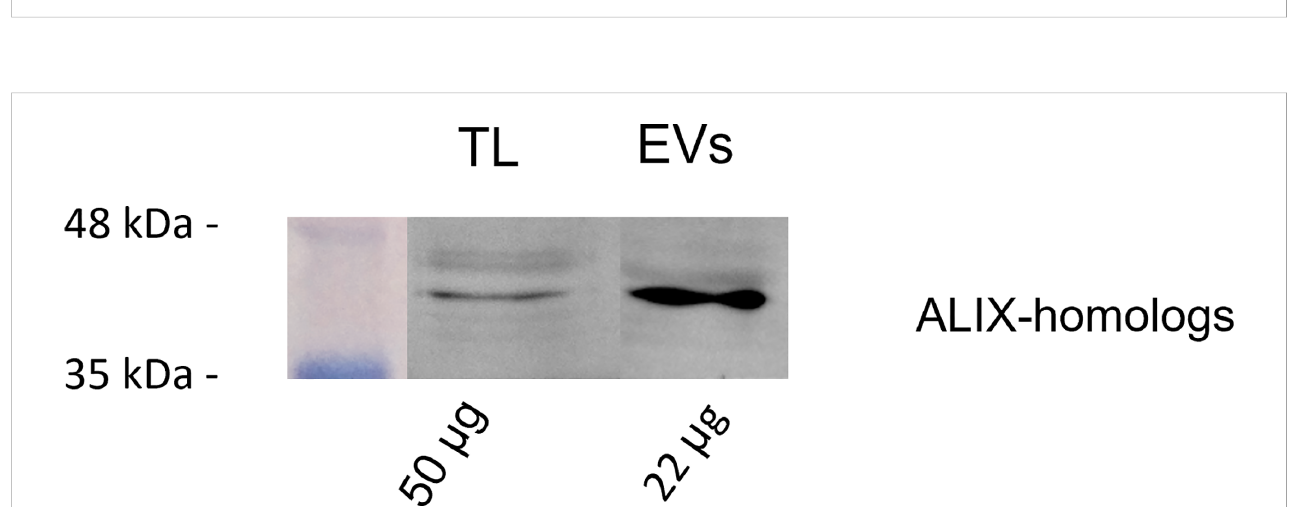
FIGURE 6 Western blot analysis of pollen total lysate (TL) and nanovesicles (EVs) fractions from germinated kiwi pollen (GKP), probed with a 1:1000 dilution of anti- ALIX rabbit polyclonal. The membranes were developed with ECL and read in chemiluminescence. On the left are reported the molecular weights of the pre-stained ladder, while on the bottom are reported the protein amounts loaded per